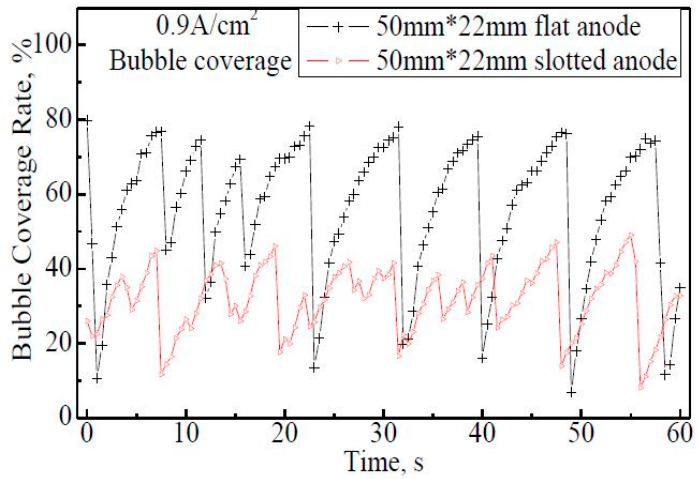
Figure 6. The bubble coverage rate on the 50 mm × 22 mm flat and slotted anodes within 60 s, apparent anode current density 0.9 A ‧ cm − 2 .